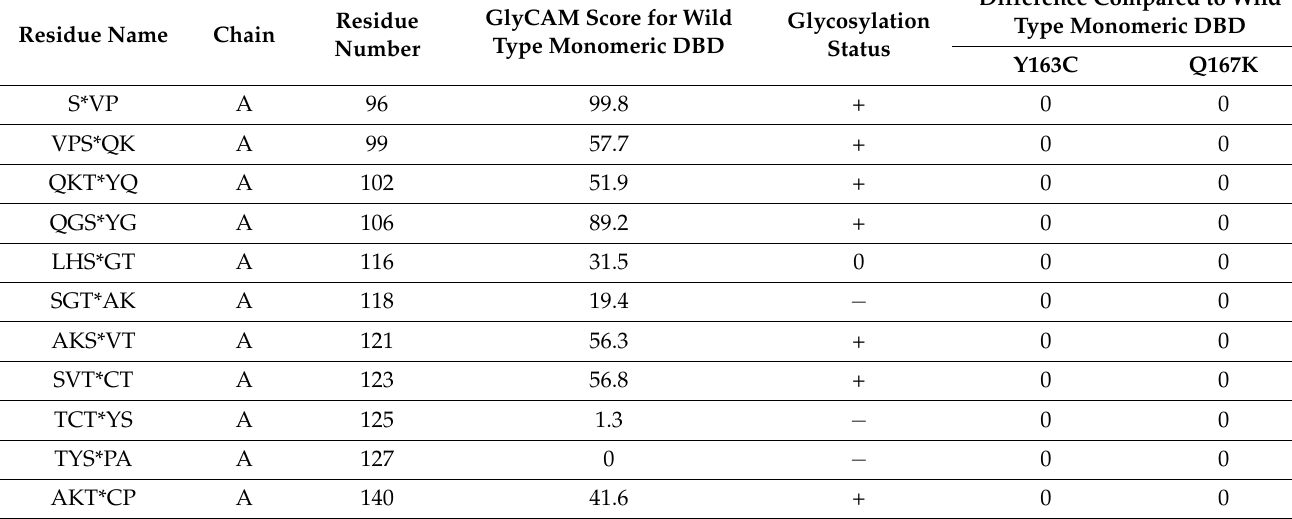
Table 1. The propensity for glycosylation of monomeric DBD of p53 96-291 taken from the crystal structure of a dimer of dimers of DBD bound to two decamers of DNA (PDB ID: 2AHI, resolution 1.8 Å, [29]). The first column is the sequence from residues i − 2 to i + 2 (residue i is marked with *); the N -terminus sequence is from i to i + 2 or i − 1 to i + 2. The second column is the identity of the chain in the pdb file. The third column is the residue number (i) of the Thr or Ser residue. The fourth column is the GLYCAM score of the particular Ser or Thr in monomeric DBD while the fifth column lists the glycosylation propensity of the residue, i.e., positive (+), zero (0), and negative ( − ), corresponding to high, low, and zero propensity for glycosylation. The sixth column is the difference between the GLYCAM score of the monomeric wild type DBD and the monomeric Y163C mutant DBD. The seventh column is the difference between the GLYCAM score of the monomeric wild type DBD and the monomeric Q167K mutant